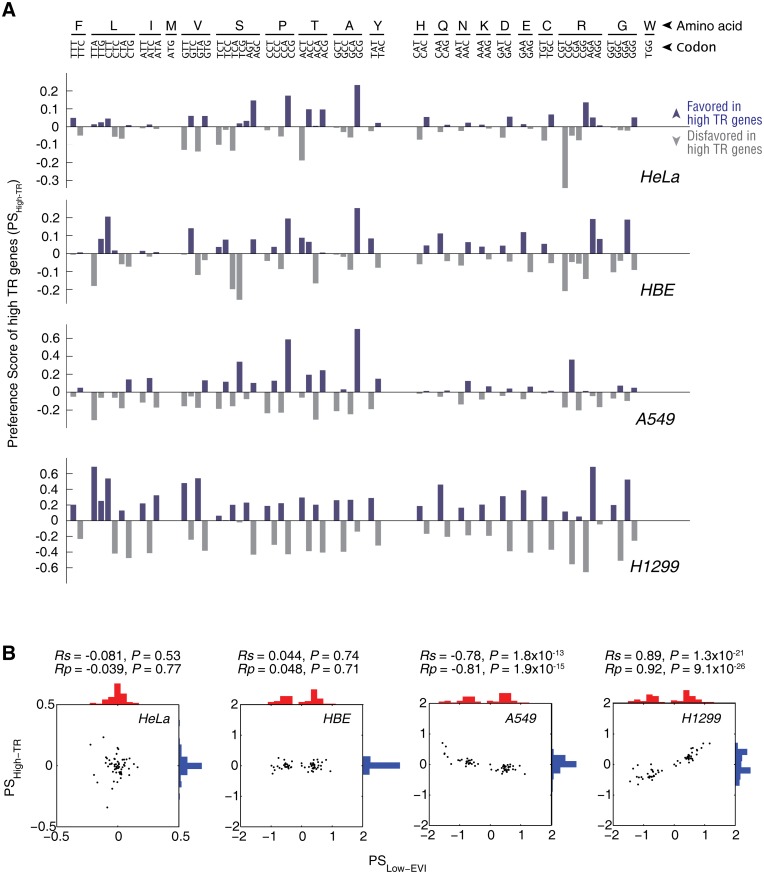
Codon preference of the high TR genes.(A) Preference Score of high TR genes (PSHigh-TR) of the four cell lines. (B) Correlation of the PSHigh-TR and PSLow-EVI.